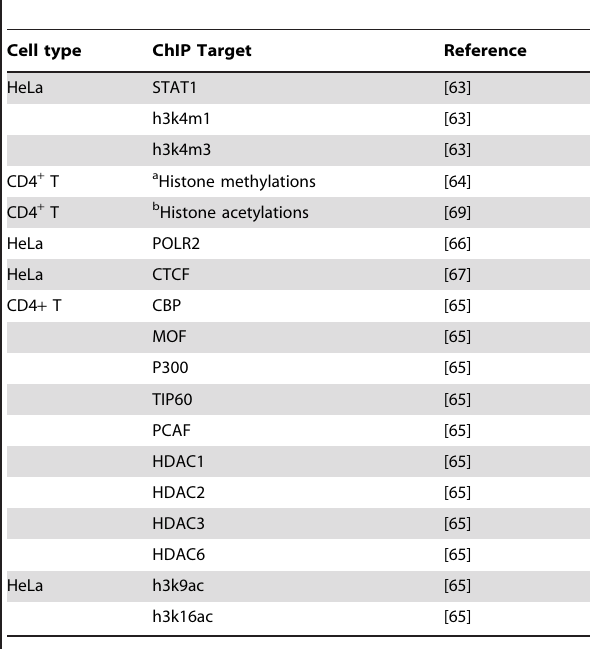
Table 1. ChIPSeq datasets from human cells used in this